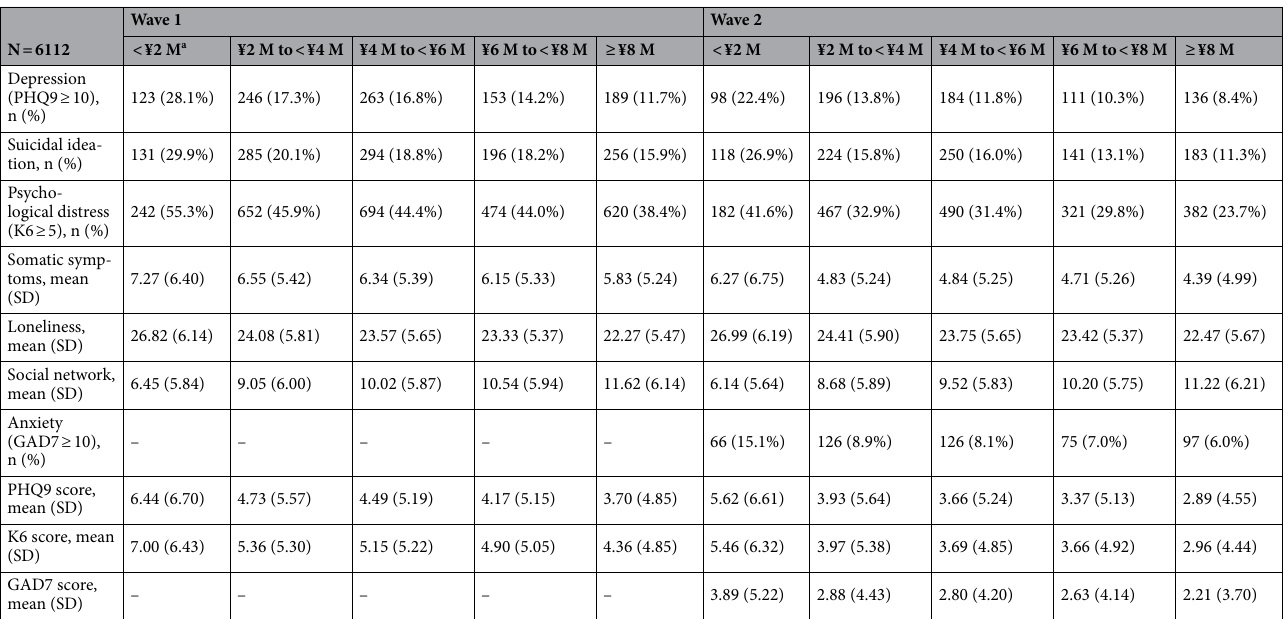
Table 4. Changes in outcome variables by income group. This table shows the results excluding the 1781 participants who answered that they did not know their income. a ¥2 M (2 million JPY) =